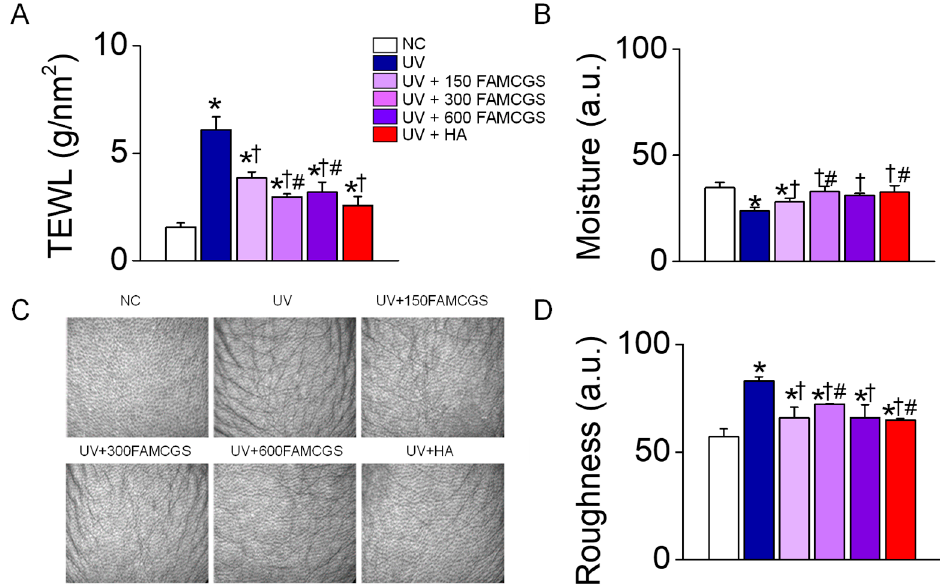
Figure 5. Dose-dependent effect of FAMCGSs on the skin barrier. ( A ) Changes in transepidermal water loss. ( B ) Skin moisture content. ( C ) Skin roughness. Representative photographs of dorsal skin. ( D ) Summarized effect of FAMCGSs on UV-induced skin roughness. Each bar represents the mean ± SD ( n = 5 in each group). * p < 0.05 compared to NC group. † p < 0.05 compared to the UV group. # p < 0.05 compared to the UV + 150 FAMCGS group.